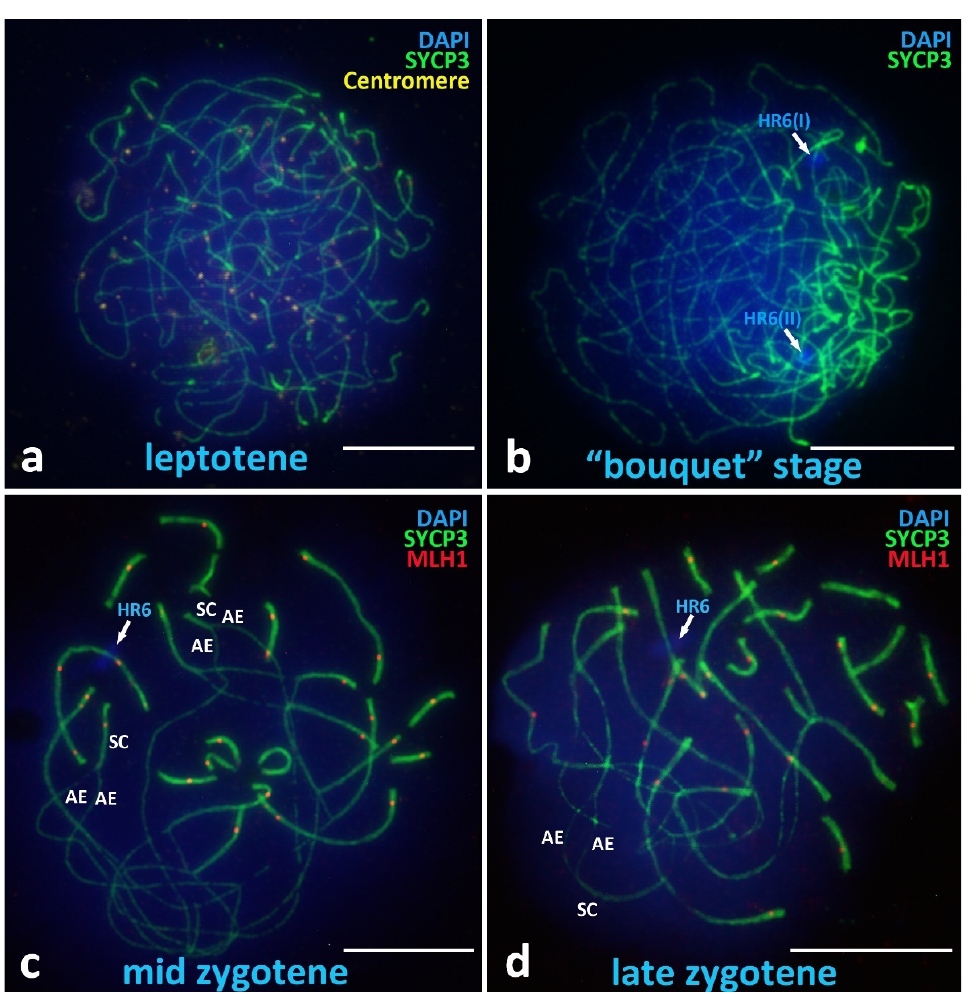
Figure 3. Presynaptic stages in V. berus primary spermatocytes. ( a ) Leptotene, long axial elements are completely asynapted, centromeres distributed over all spread nuclei. ( b ) Chromosomal ‘bouquet’ stage, U-shaped axial elements of chromosomes, clusterization of telomere ends in the local region of the spread nucleus. ( с ) Mid zygotene, asynchronous synapsis of the long chromosomes and microchromosomes. MLH1 protein loaded in bivalents of microchromosomes as well as in the regions of local synapsis of long assembling bivalents. ( d ) Late zygotene, finalization of assembly of the long bivalents. Bivalents of microchromosomes are fully assembled. Heterochromatin region on the chromosome pair 6 is indicated as HR6. AE—axial elements of asynapted chromosomes. SC—assembled regions of synaptonemal complexes. Axial elements of chromosomes are immunostained with antibodies against the SYCP3 protein (green), centromeres with antikinetochore antibodies ACA (yellow). Mismatch repair protein sites are immunostained with antibodies against MLH1 protein (red). Chromatin stained with DAPI (blue). Bar—10 μ m.